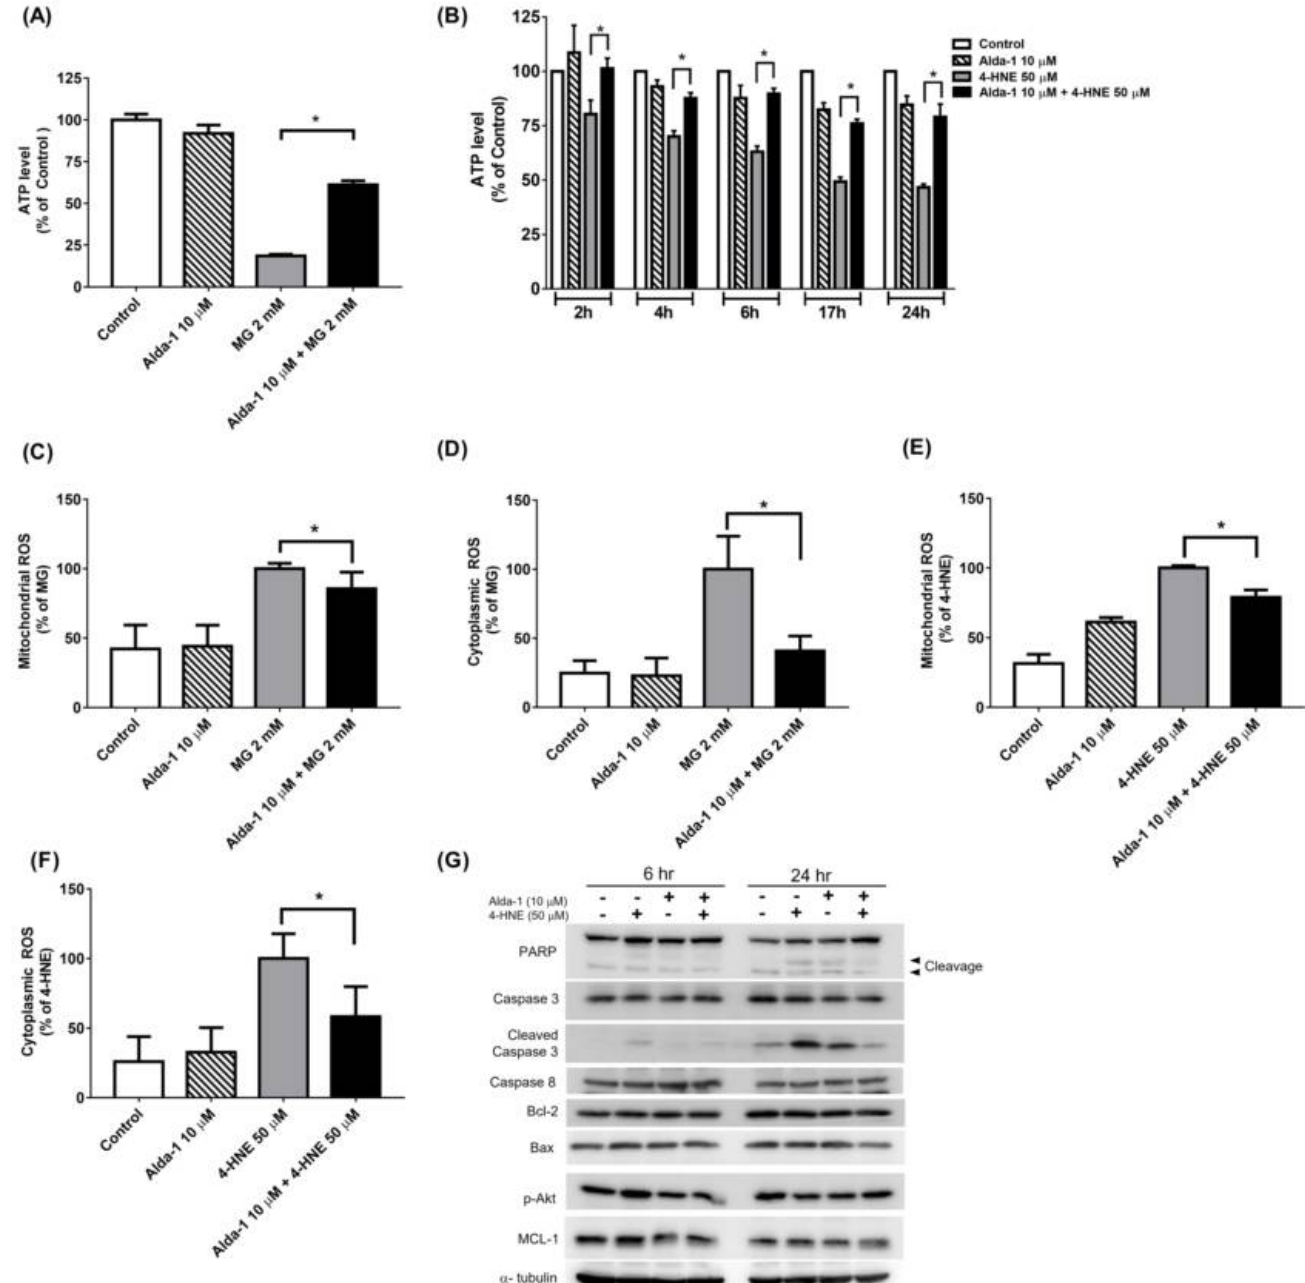
Figure 4. Alda-1 ameliorates mitochondrial dysfunction induced by glucotoxicity and lipotoxicity. The ATP levels in the control and Alda-1-treated MIN6 cells in the absence and presence of 2 mM methylglyoxal (MG) for 24 h ( A ) or 4-HNE for different time periods ( B ). Relative mitochondrial ( C,E ) and cytoplasmic ( D,F ) ROS levels normalized to MG or 4-HNE in the control and Alda-1-treated MIN6 cells in the absence and presence of 2 mM MG ( C,D ) or 4-HNE ( E,F ) for 24 h. ( G ) The signaling pathway of Alda-1 rescuing 4-HNE-induced cell apoptosis. Treatment of Alda-1 improved the beneficial effects on apoptotic protein levels. Data are presented as mean ± SEM of three independent experiments (n = 3 per group). * p < 0.05.